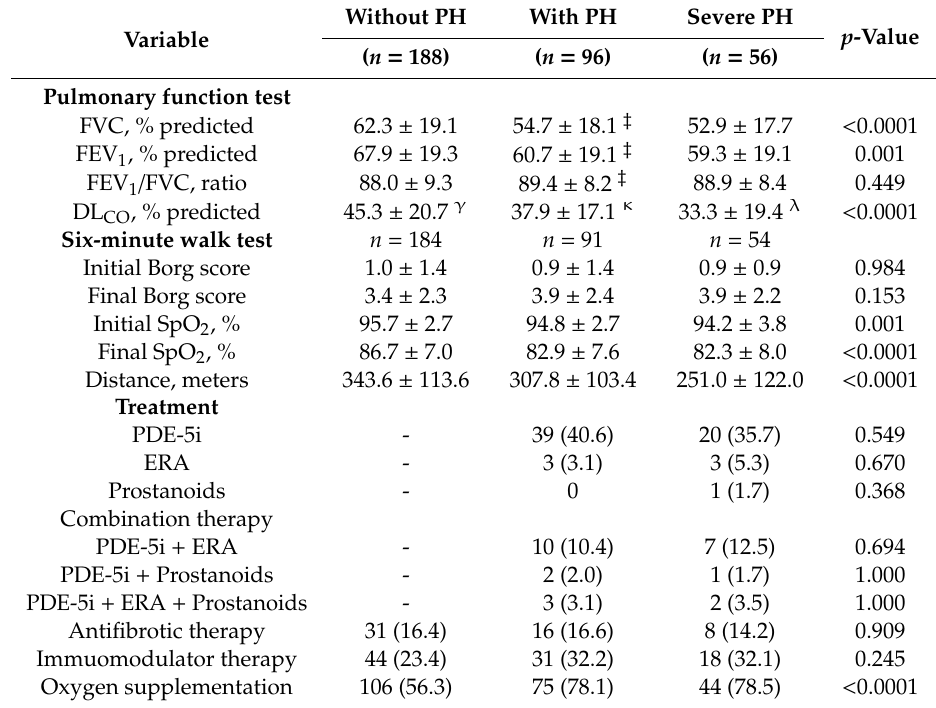
Table 2. Clinical characteristics of the study cohort.